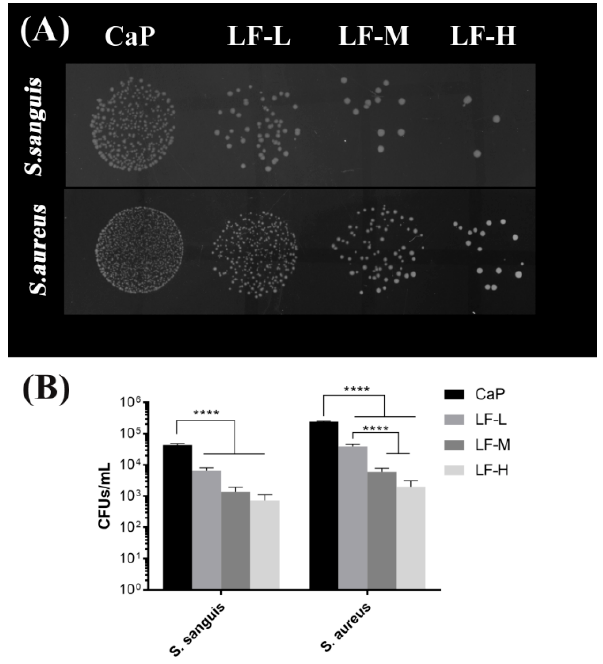
Figure 5. Spot assay ( A ) and colony-forming units (CFUs, B ) of adhesive S. sanguis and S. aureus on CaP, LF-L, LF-M, and LF-H specimens cultured for 24 h. **** p < 0.0001. The results for the antibacterial proliferation are shown in Figure 6. The absorbance of each sample was at a low level in the 1st hour (Figure 6A). After culturing for 4 and 24 h, both the results of S. sanguis and S. aureus showed that the absorbance of the CaP group was significantly higher than that of the other groups (LF-L, LF-M, and LF-H). Figure 6B shows the results of the spread plate method. The bacterial colonies ( S. sanguis and S. aureus ) of the experimental groups (LF-L, LF-M, and LF-H) were smaller than those of the control group (CaP), and even fewer bacterial colonies could be observed on LF-M and LF-H, no matter whether the bacteria was incubated with Ti samples for 4 or 24 h.